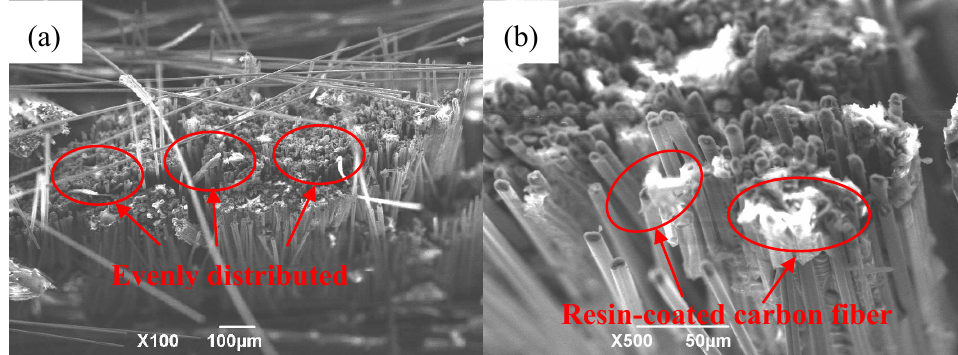
Figure 11. Bending fracture morphology of 2D-CFRP composites: ( a ) bending fracture of 2D-CFRP ( × 100); ( b ) bending fracture of 2D-CFRP ( 500).